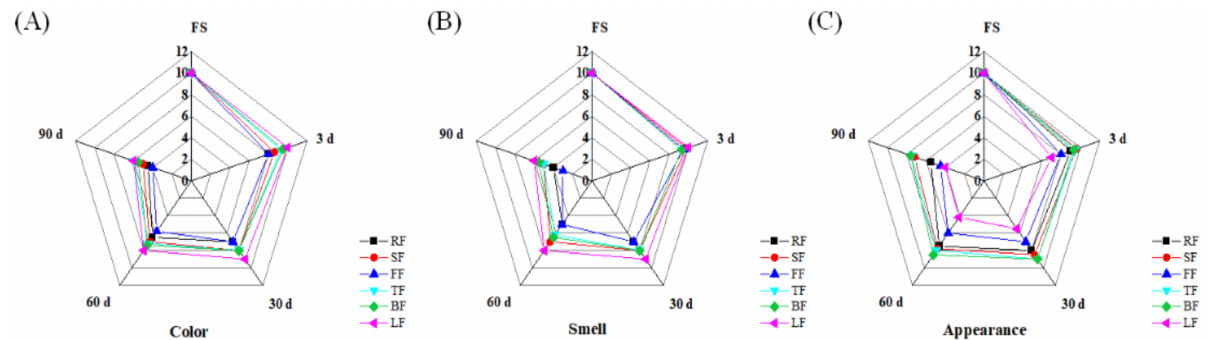
Figure 11. Change in color ( A ), smell ( B ), appearance ( C ) of cuttlefish during storage at − 18 ◦ C by different freezing methods (FS represents fresh